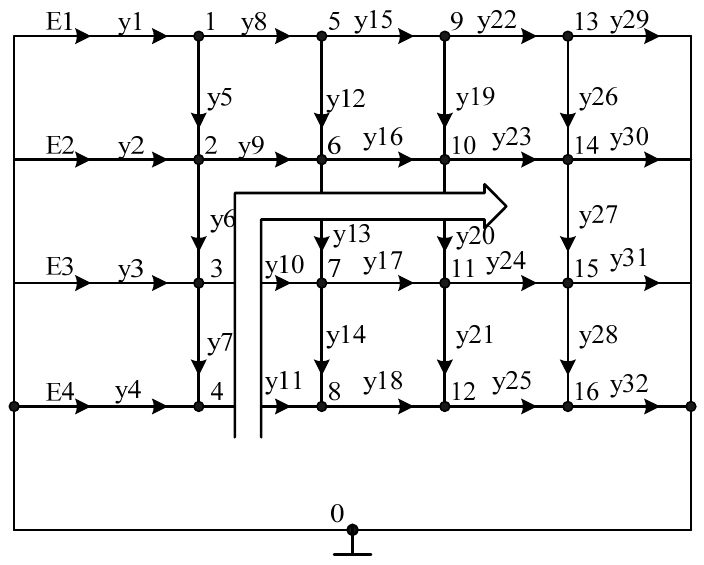
Figure 5. Oriented graph of the simplified circuit model with trimming trajectory.